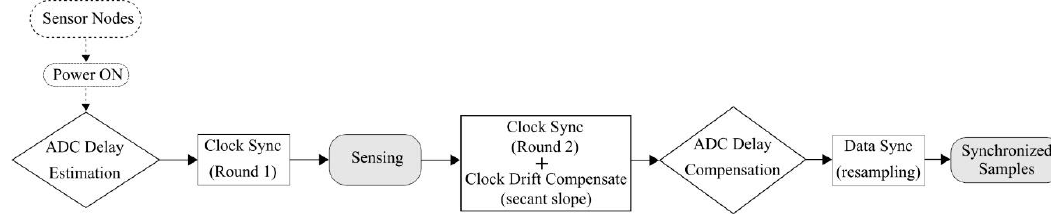
Figure 9. Flowchart of synchronized sensing framework.